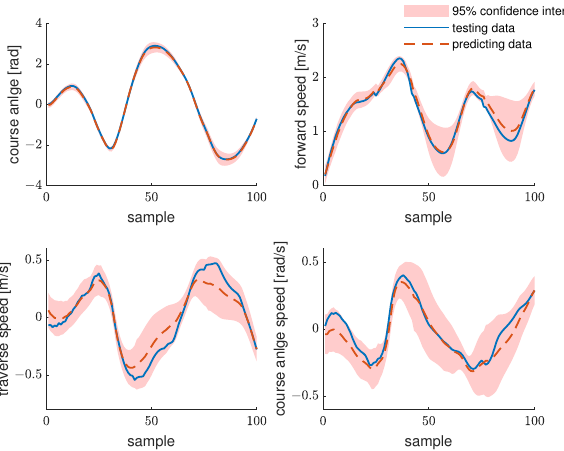
Figure 12. Results of Gaussian model predictions. Prediction results for heading, forward speed, lateral speed, and yaw angle speed for the test data in the case of 50 learning samples. The solid blue line in the figure shows the actual data, the dashed orange line shows prediction results, and the red area shows the 95% confidence interval.